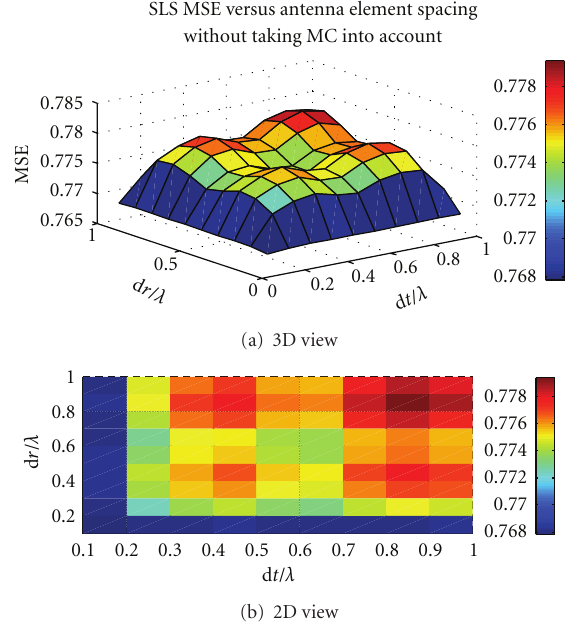
Figure 6: SLS MSE versus transmitter and receiver antenna element spacing without taking MC into account.